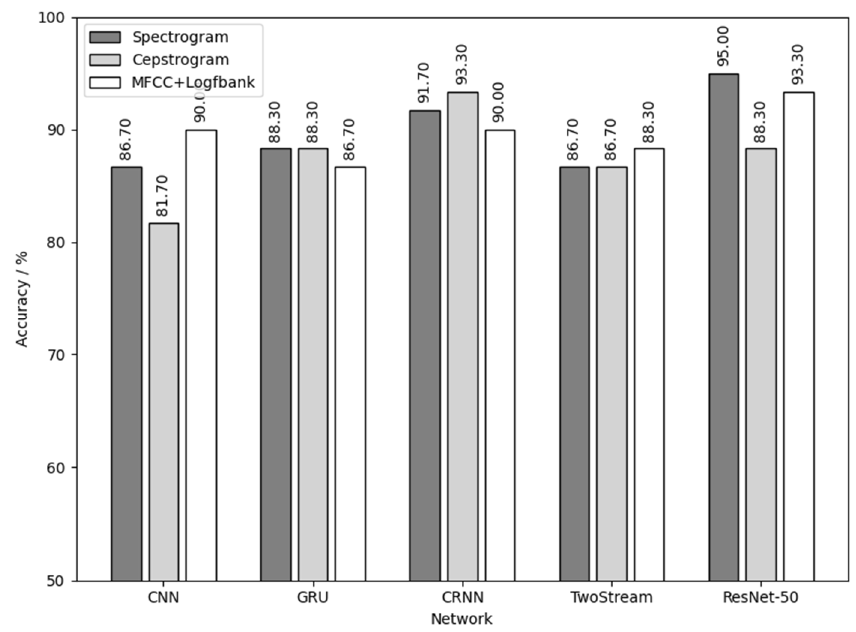
Figure 19. Three yellow chick calls used for training and to detect the sex of the three yellow chicks.